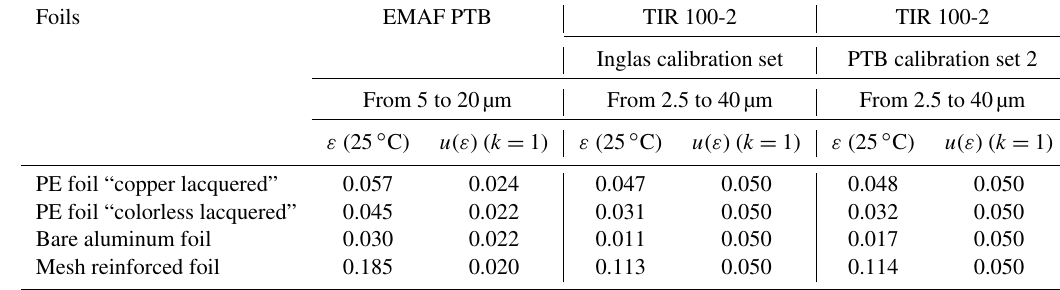
Table 5. The directional total emissivities and standard uncertainties of selected foils measured at the EMAF and using the TIR 100-2 with the two different calibration sets.